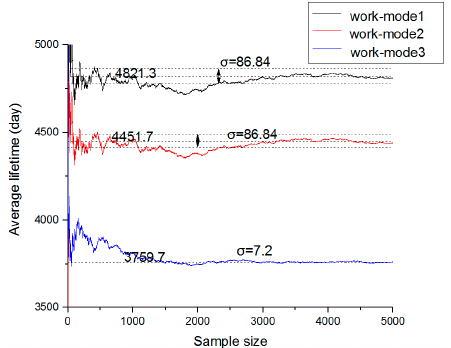
Figure 24. Life prediction of the FS with Configuration 1 in different work modes.